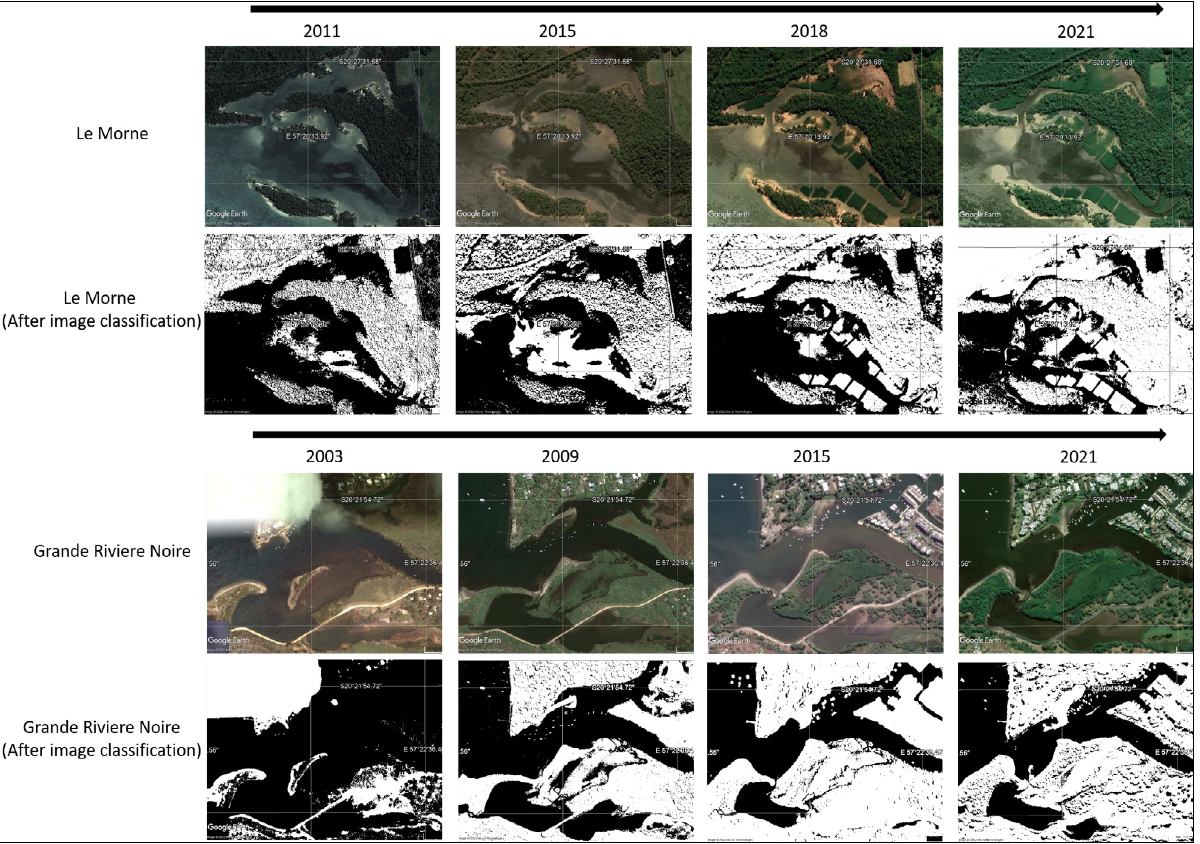
Figure 3: Google Earth Pro images of Le Morne (from 2011 to 2021) and Grande Rivière Noire (from 2003 to 2021) before and after image